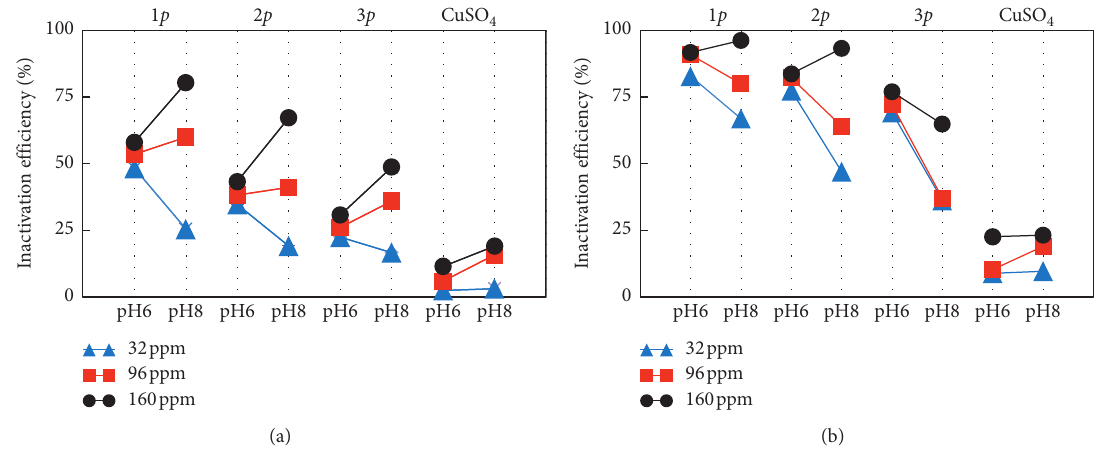
Figure 5: Interaction of incubation pH and copper dose on inactivation efficiency after treating E. coli for 1h (a) and 24h